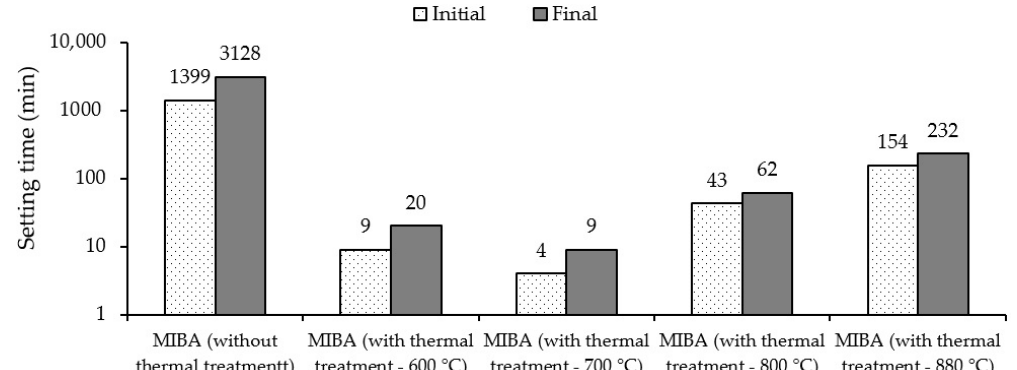
Figure 3. Effect of thermally treated and untreated MIBA on the setting time of pastes (adapted from Qiao et al.